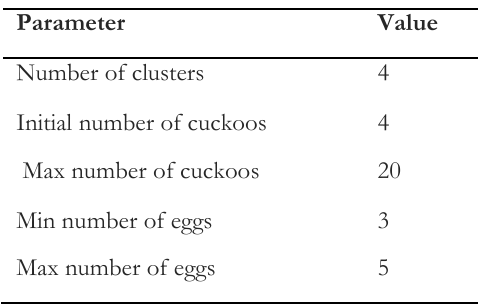
Table 4. Optimal values of the cuckoo meta-heuristic algorithm parameters for the proposed logistics